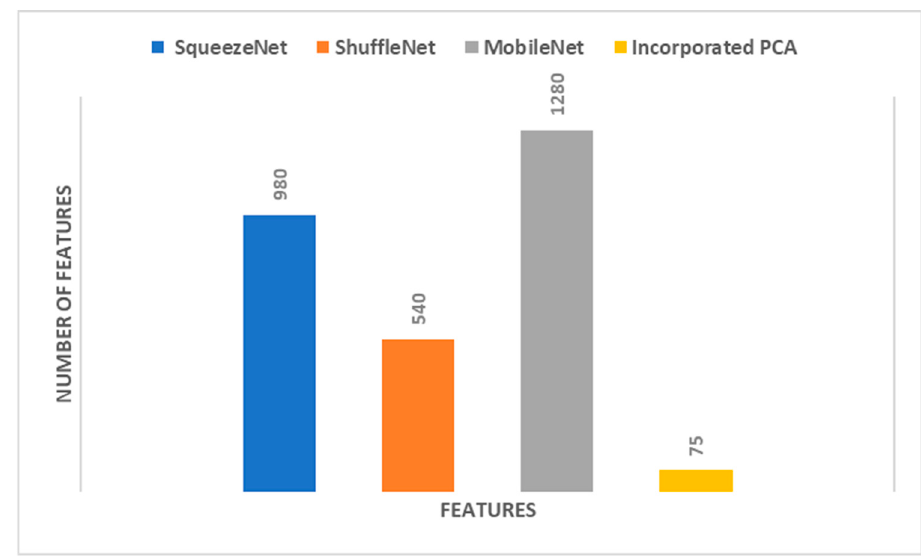
Figure 4. Number of features of each of the deep features extracted from the three CNNs compared to the incorporated reduced features of PCA used to train the four machine learning classifiers.